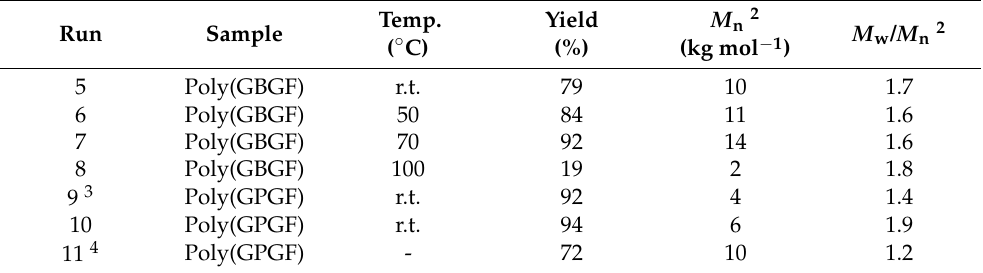
Table 2. Synthesis of Poly(GBGF) and Poly(GPGF) 1 .